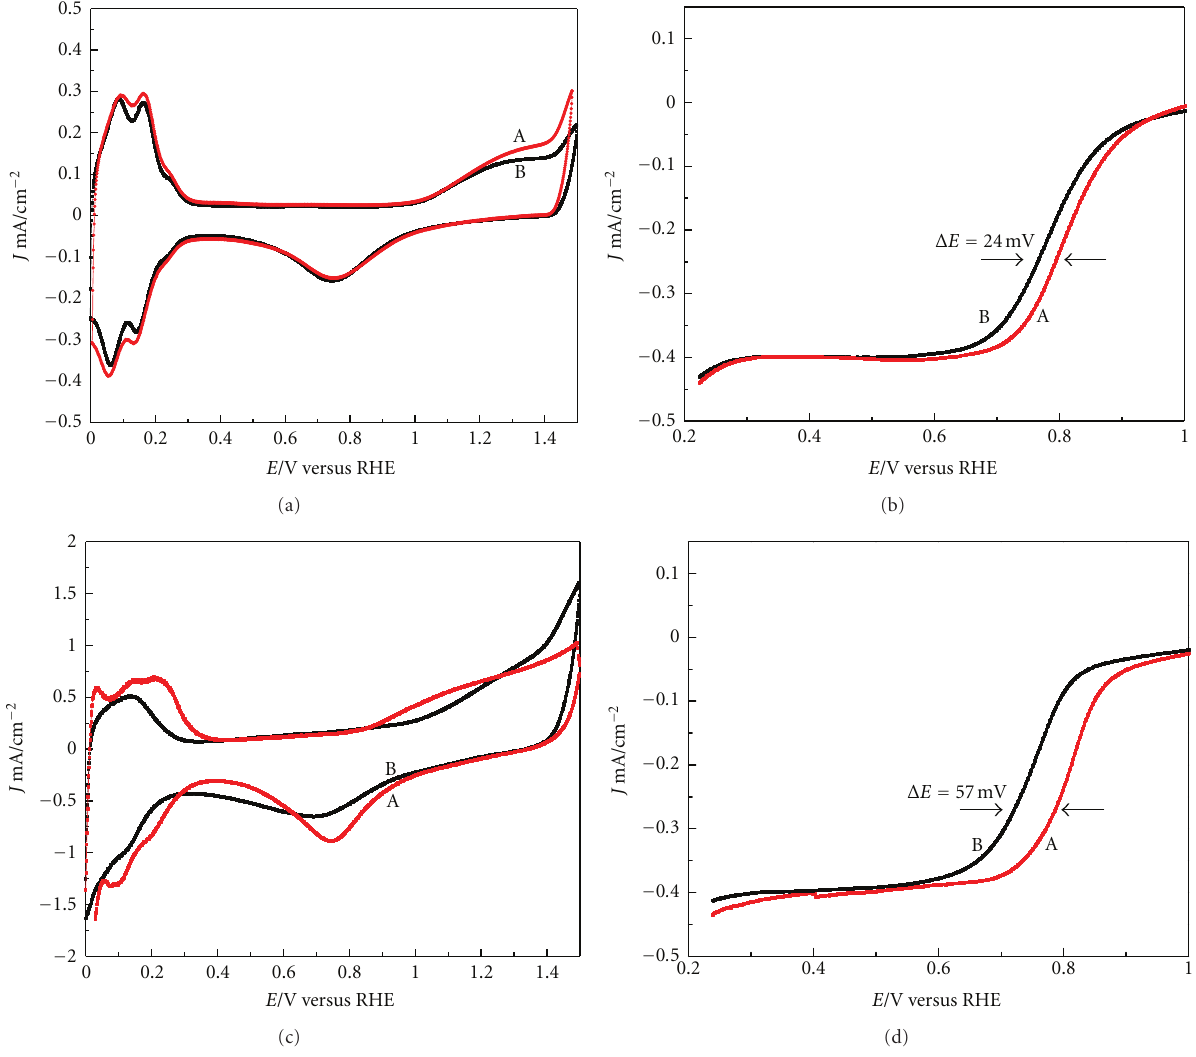
Figure 7: CVs (a) and (c) in 0.5 M H 2 SO 4 solution purged with N 2 at scan rate of 100mVs − 1 and ORR polarization curves (b) and (d) in O 2 -saturated HClO 4 (0.1M) solution at scan rate of 10 mVs − 1 for GCE-supported (a) and (b) Pt 53 -on-NiCo nanostructures and (c) and (d) Pt catalysts before (a) and after (b) 30.000